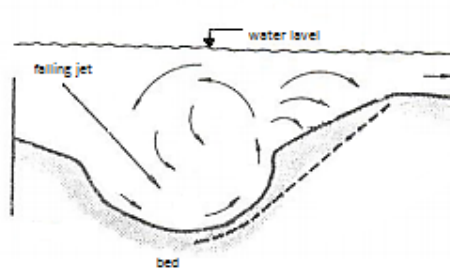
Figure1. Flow pattern of falling jet in score